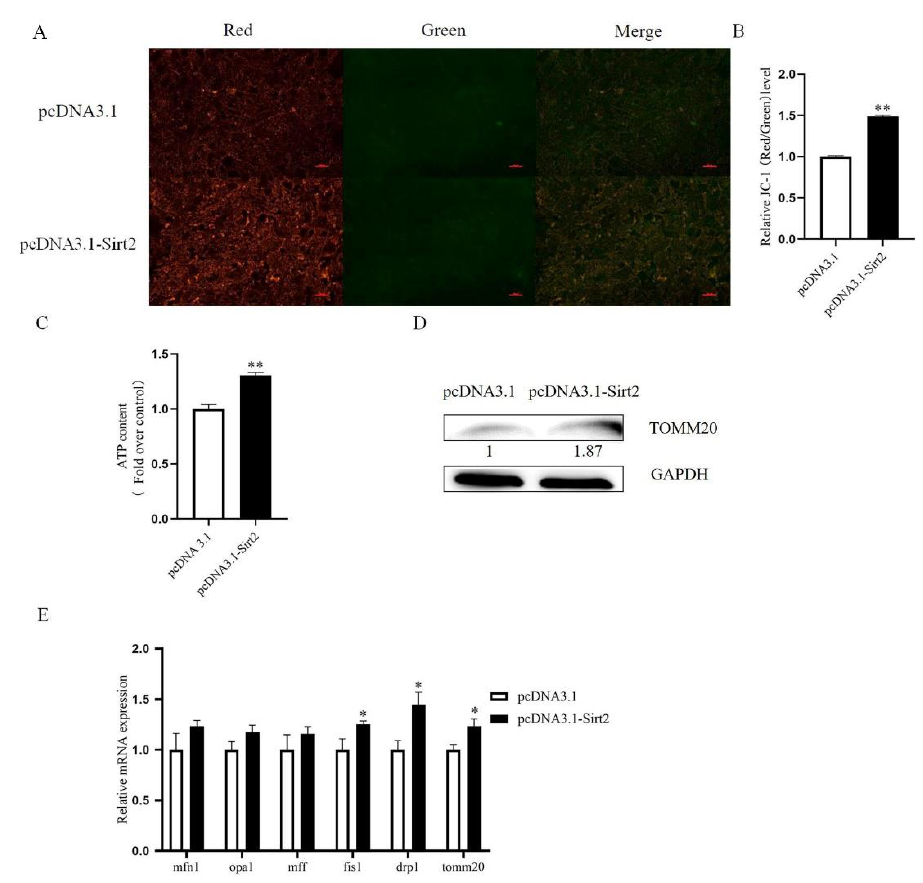
Figure 6. Overexpression of Sirt2 in granulosa cells affects mitochondrial function. ( A ) Mitochondrial membrane potential (red and green fluorescence) in the control group and Sirt2 overexpression group after JC-1 treatment. Bar = 100 µ m. ( B ) Intensity of mitochondrial membrane potential after Sirt2 overexpression. ( C ) ATP relative levels after overexpression of Sirt2. ( D ) Western blot detected the protein level of mitochondrial protein TOMM20 after Sirt2 overexpression. ( E ) The expression of granulosa cell mitochondrial genes (mfn1, opa1, mff, fis1, drp1, and tomm20) was detected by qRT-PCR after overexpression of Sirt2. The graph shows the mean ± SEM of the results obtained in three independent experiments. *, significant difference ( p < 0.05). **, significant difference ( p < 0.01).